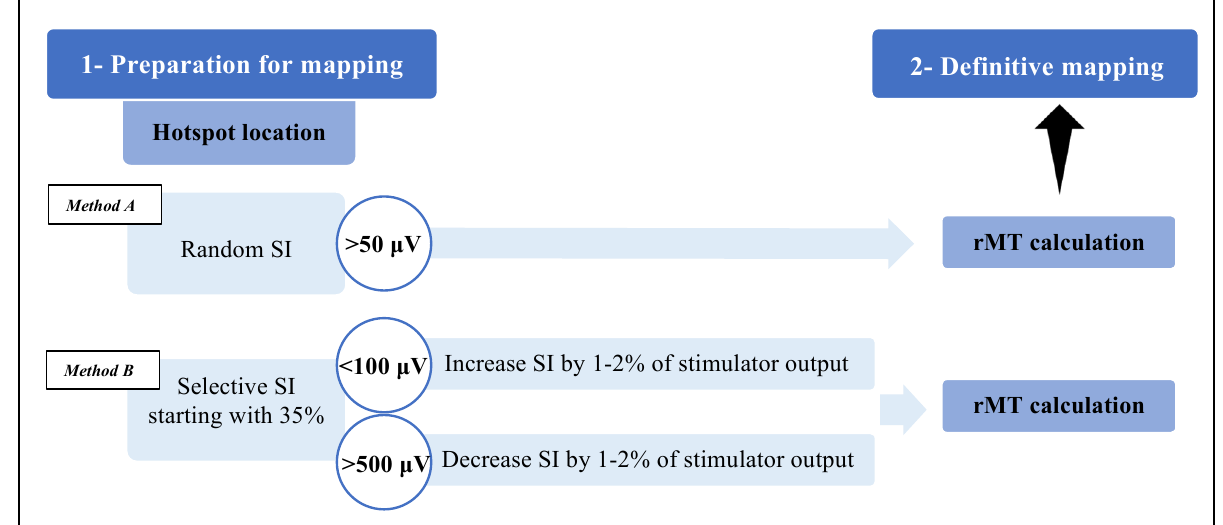
Figure 2. Schematic representation of mapping phases with two different hotspot search methods. The procedural scheme ranges from an initial preparation phase to final mapping via hotspot search and rMT calculation. The hotspot search method in group B considers MEP amplitudes to adjust stimulation intensity (SI), which starts from a standard value of 35%, while in group A, SI is chosen randomly and does not consider response characteristics.